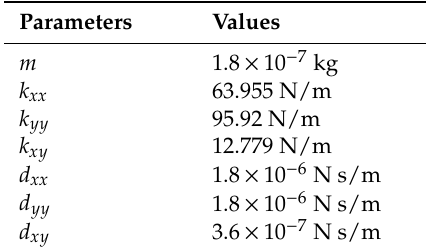
Table 1. Parameters of micro